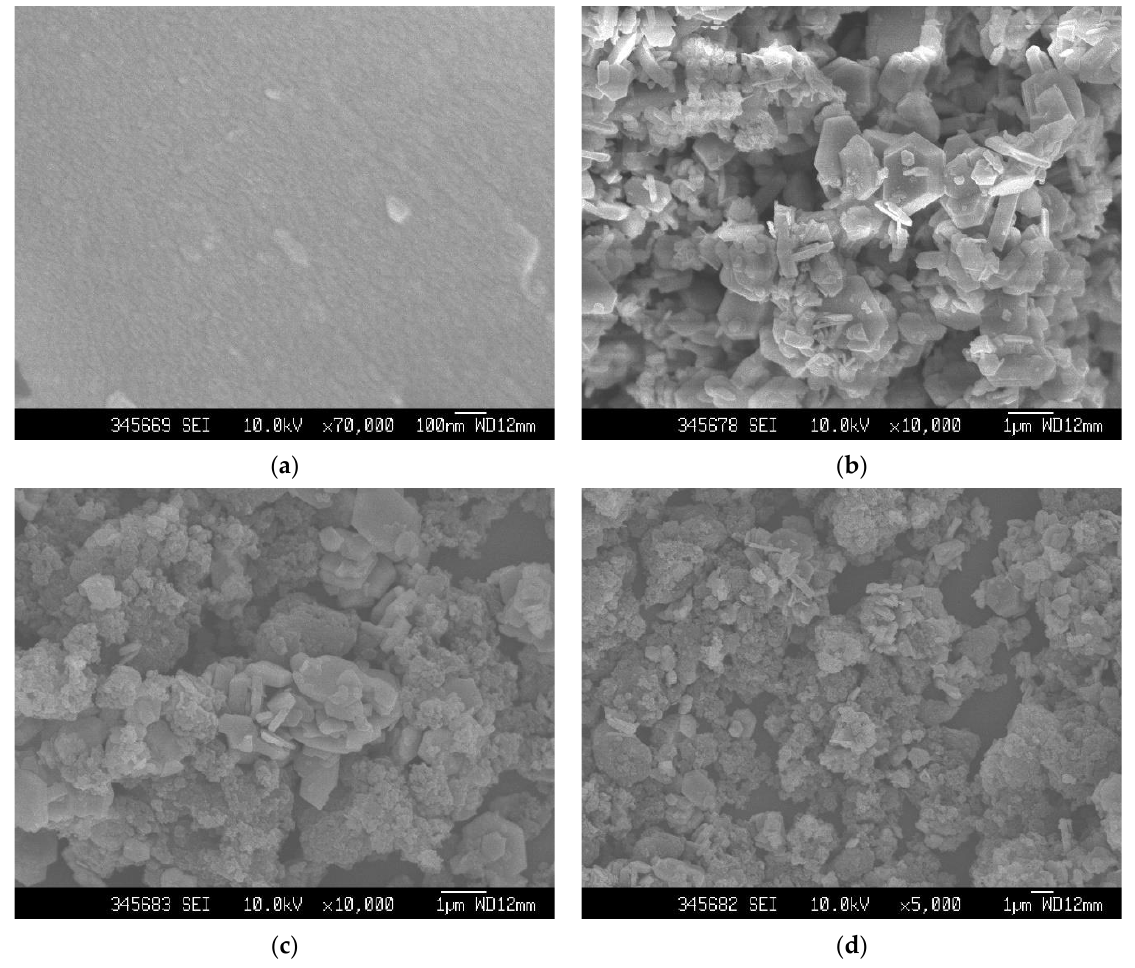
Figure 4. SEM images of ( a ) PPy and ( b – d ) BaFe 12 O 19 -PPy nanocomposite samples 1, 5, and 8.